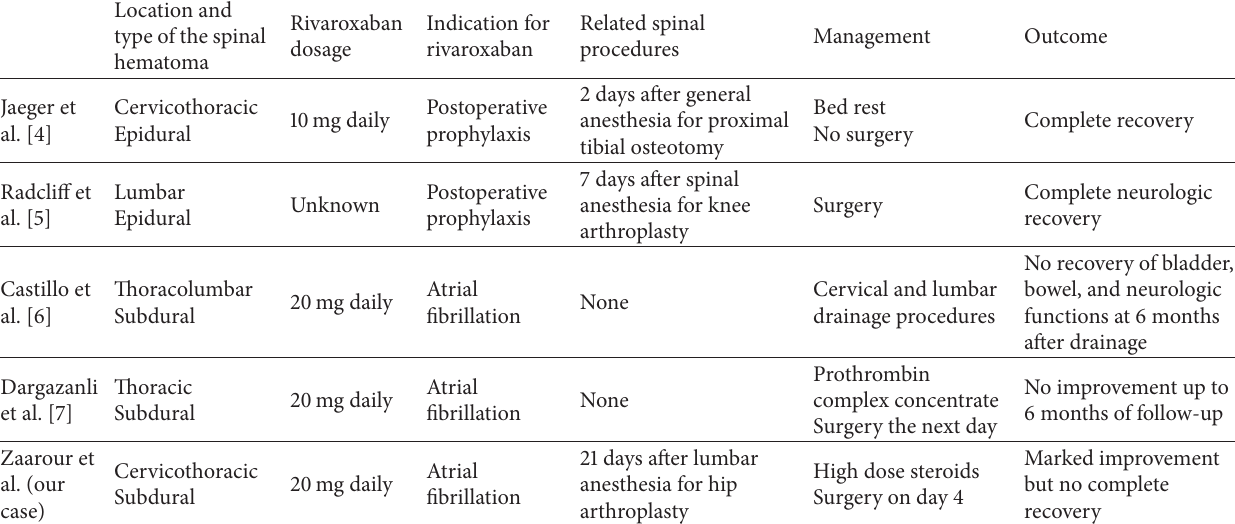
Table 1: Summary of the cases of rivaroxaban-associated nontraumatic spinal